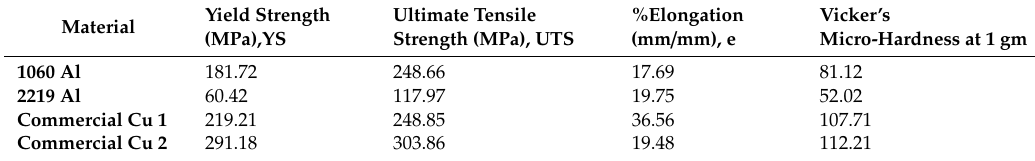
Table 3. Mechanical properties of base metals.